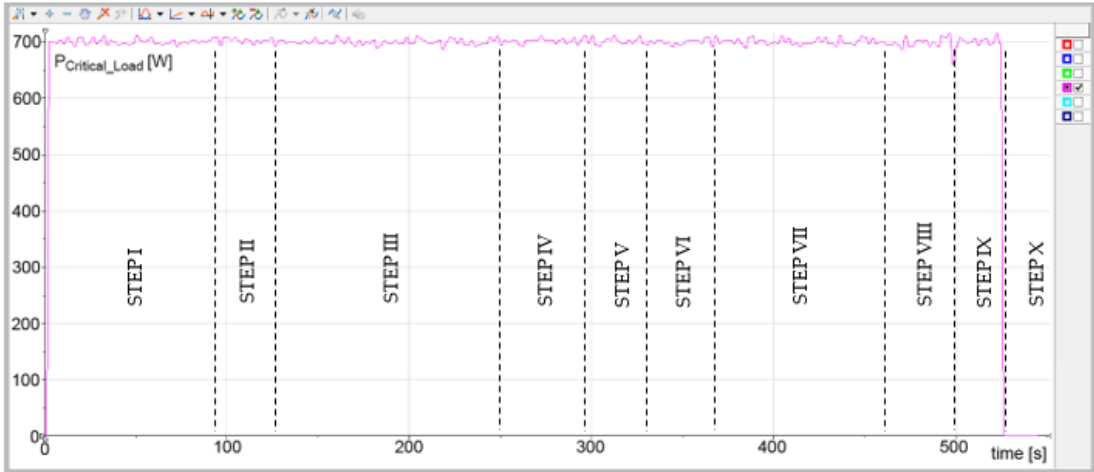
Energies 2018 , 11 , x FOR PEER REVIEW